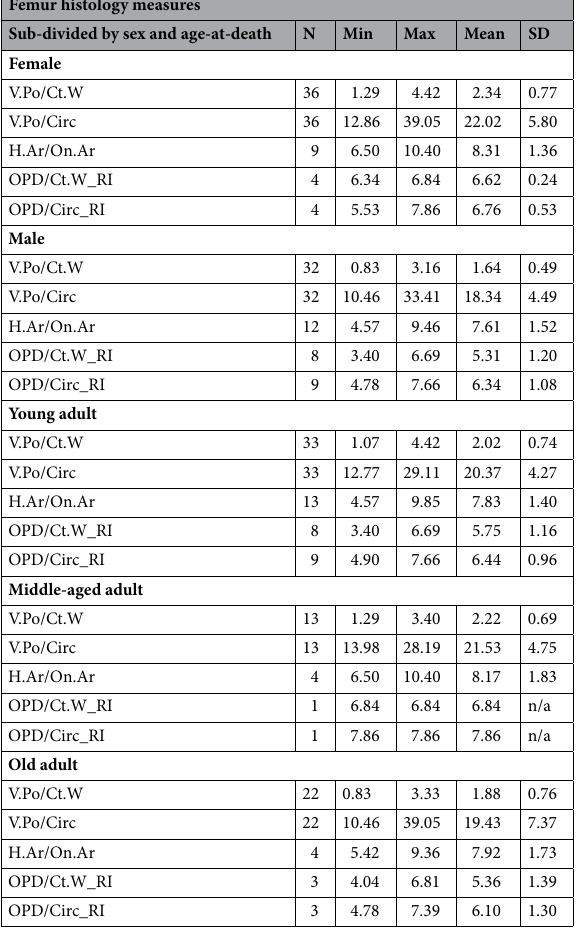
Comparisons Males vs. females Bone histology markers compared between males and